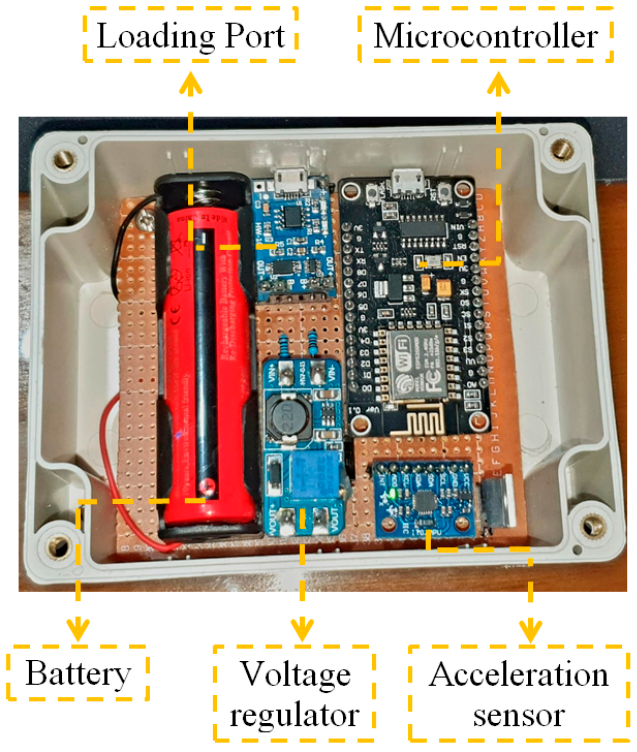
Figure 4. Sensor node structure and